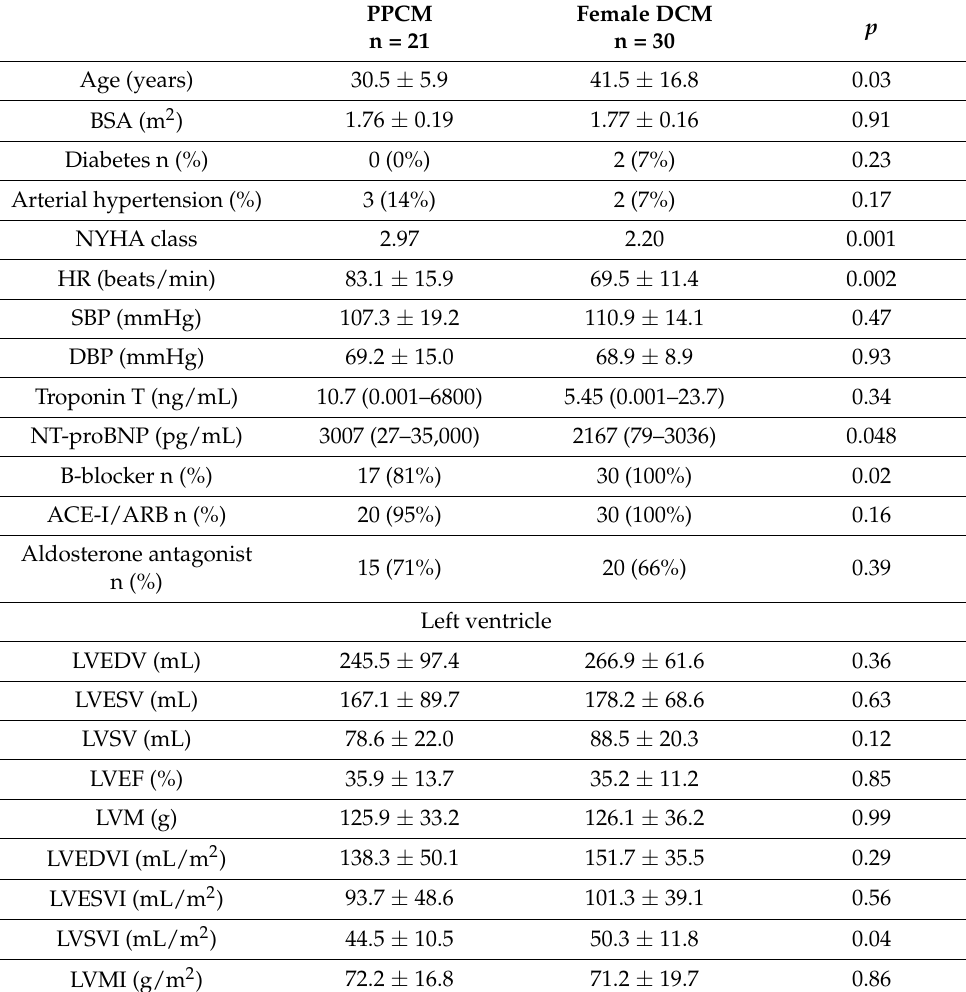
Table 1. Volumetric and functional CMR characteristics between patients with PPCM and female patients with